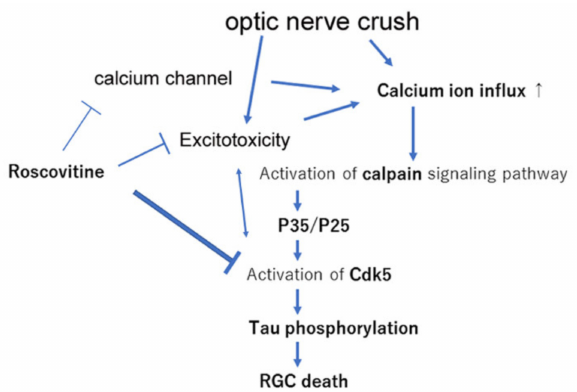
Figure 7. Schematic diagram illustrating the effects of roscovitine. Optic nerve crush increases calcium influx and activates the calpain signaling pathway, which then activates Cdk5 through a mechanism involving P35/P25. Activation of Cdk5 causes abnormal phosphorylation of tau, leading to the death of the RGCs. Roscovitine reduces the degree of activation of Cdk5 and decreases the abnormal phosphorylation. Cdk5 is also associated with excitotoxicity, and roscovitine may decrease calcium influx through a mechanism involving excitotoxicity. In addition, roscovitine may block some calcium channels and thereby suppress the calpain signaling